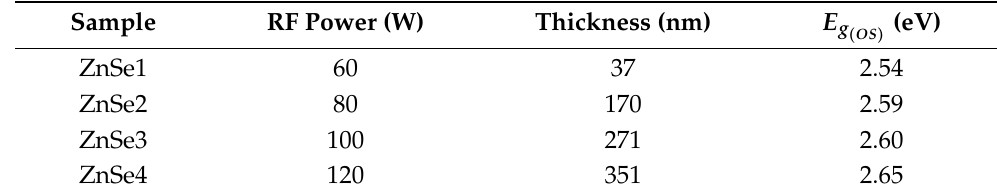
Table 3. Calculated band gap ( E g ) values (from OS analysis) of the ZnSe thin films sputtered at an ( OS ) RF power of: 60 W, 80 W, 100 W and 120 W. Corresponding thickness values of the films, as measured by SEM, are indicated as well.